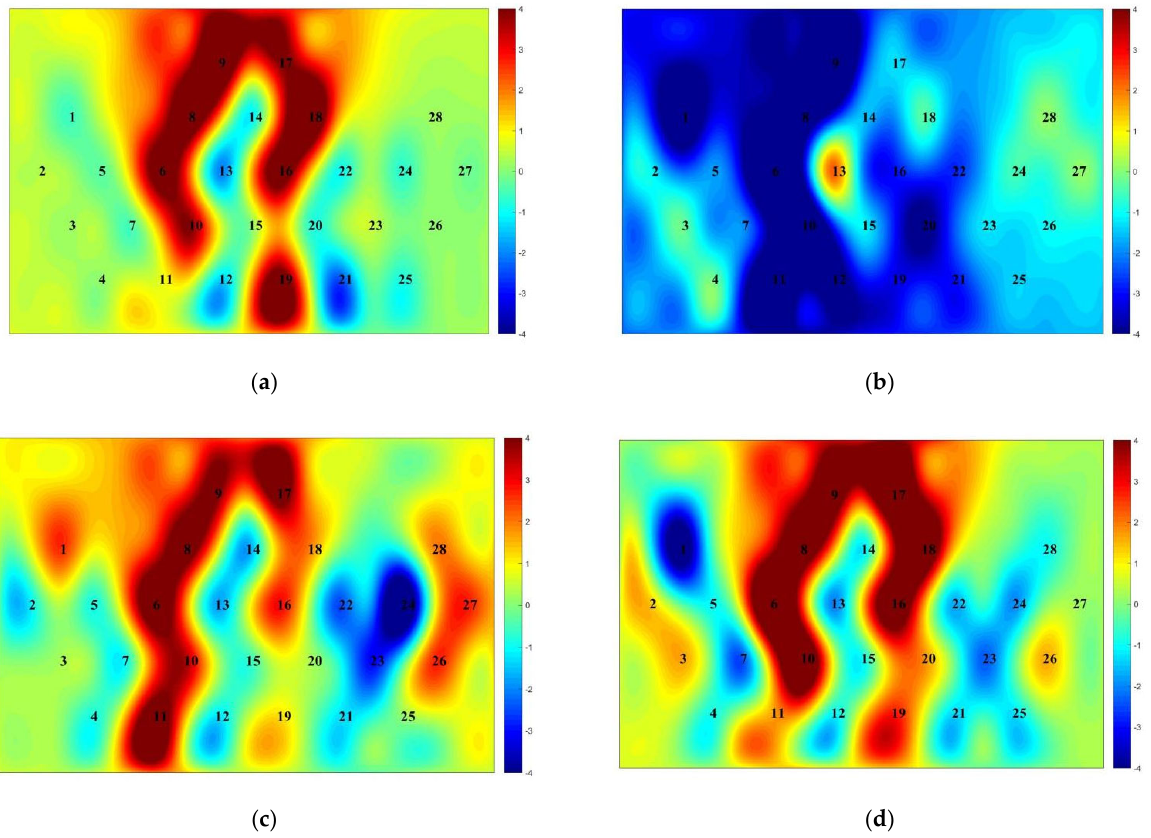
Figure 8. Activation map of prefrontal lobe in experimental group and control group before and after exercise intervention. ( a ) Experimental group pre ‐ test; ( b ) experimental group post ‐ test; ( c ) control group pre ‐ test; ( d ) control group post ‐ test. The numbers represent the 28 channels of the prefrontal lobe and the colors represent the level of activation of the prefrontal lobe, with redder colors representing higher activation and bluer colors representing lower activation.